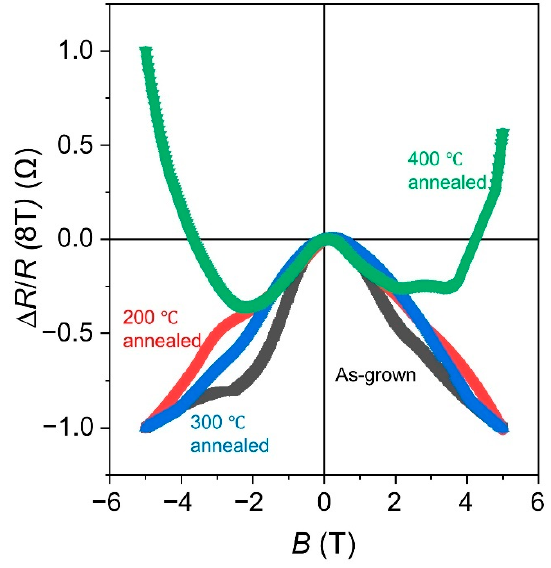
Figure 6. Magnetoresistance behavior of samples (as grown, 200 °C, 300 °C, and 400 °C RTA for 10 min) at 300 K. Magnetoresistance values are normalized with Δ R divided by R (at 5 T).